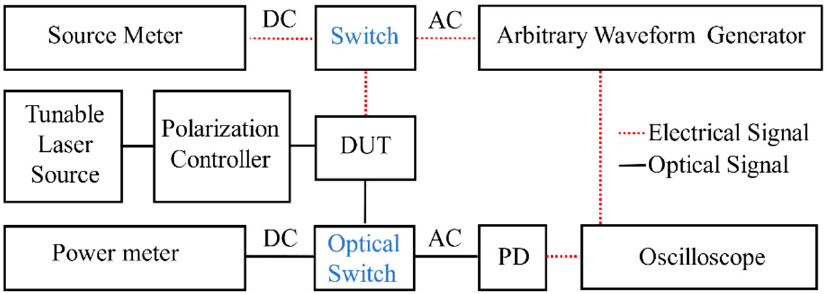
Figure 3. The block diagram of the measurement setup for DC and AC characterization. DUT: Device under test. PD: Photodetector.